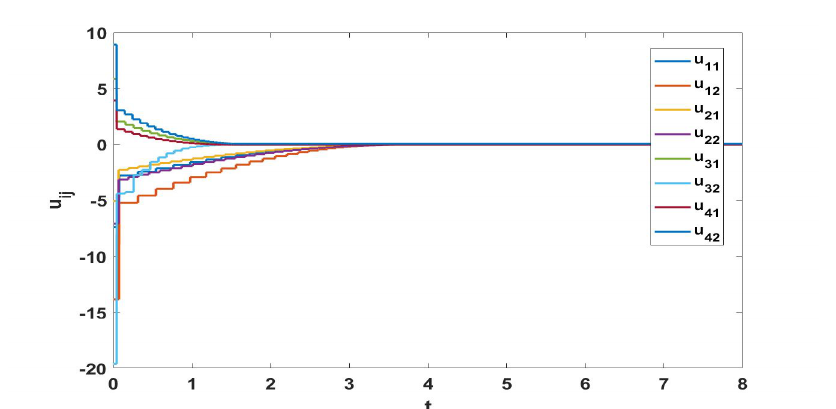
Figure 9. The trajectories of control input in Example 1.